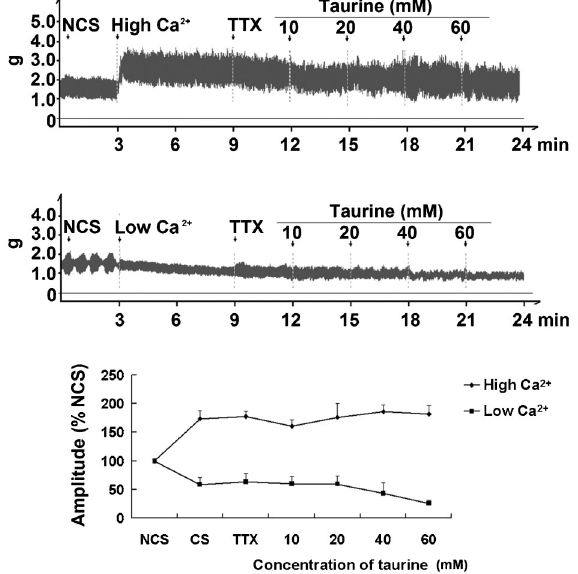
Figure 3. Effects of taurine on the contractile amplitude of isolated jejunal segments pretreated with tetrodotoxin (TTX). Representative traces and statistical analysis (n=6) of taurine- induced effects on the contractile amplitude of isolated jejunal segments in the normal contractile state (NCS, control), high contractile state (HCS) induced by high Ca 2++ (5.0 mM) Krebs buffer and low contractile state (LCS) induced by low Ca 2++ (1.25 mM) Krebs buffer pretreated with TTX (0.3 m M). The contractile amplitude in NCS is set to 100%; other data are the relative values compared with NCS. CS: contractile